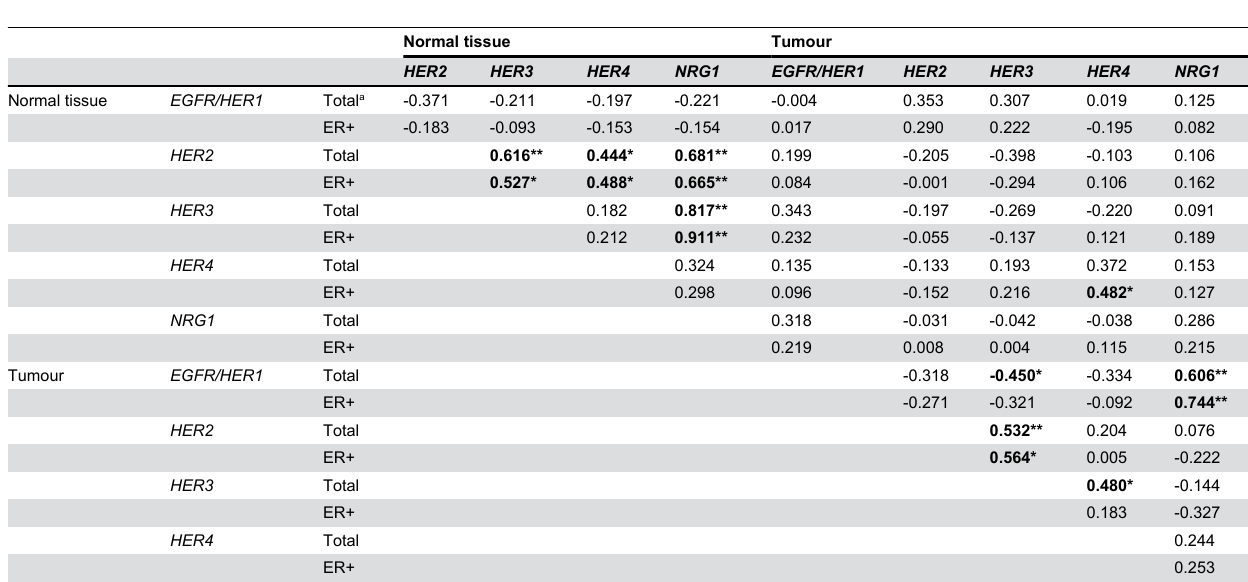
Table 4. Correlations between HER-receptors and NRG1 in normal and breast tumour tissue among postmenopausal women.